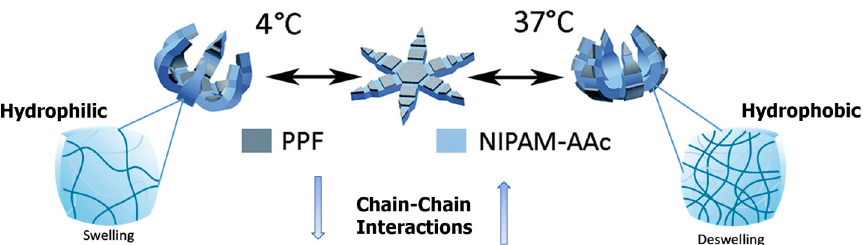
Figure 3. Mechanism of pNIPAM and PPF thermoresponsive microgrippers. At temperatures below the LCST of 36 °C, the pNIPAM-AAc polymer acts hydrophilic and swells, causing the microgripper to self-fold. Above 36 °C, pNIPAM-AAc acts hydrophobic, and the hydrogel network shrinks, causing the microgripper to fold in the opposite direction. Adapted with permission from Ref. [13] Copyright 2020 and [14]. Copyright 2014.